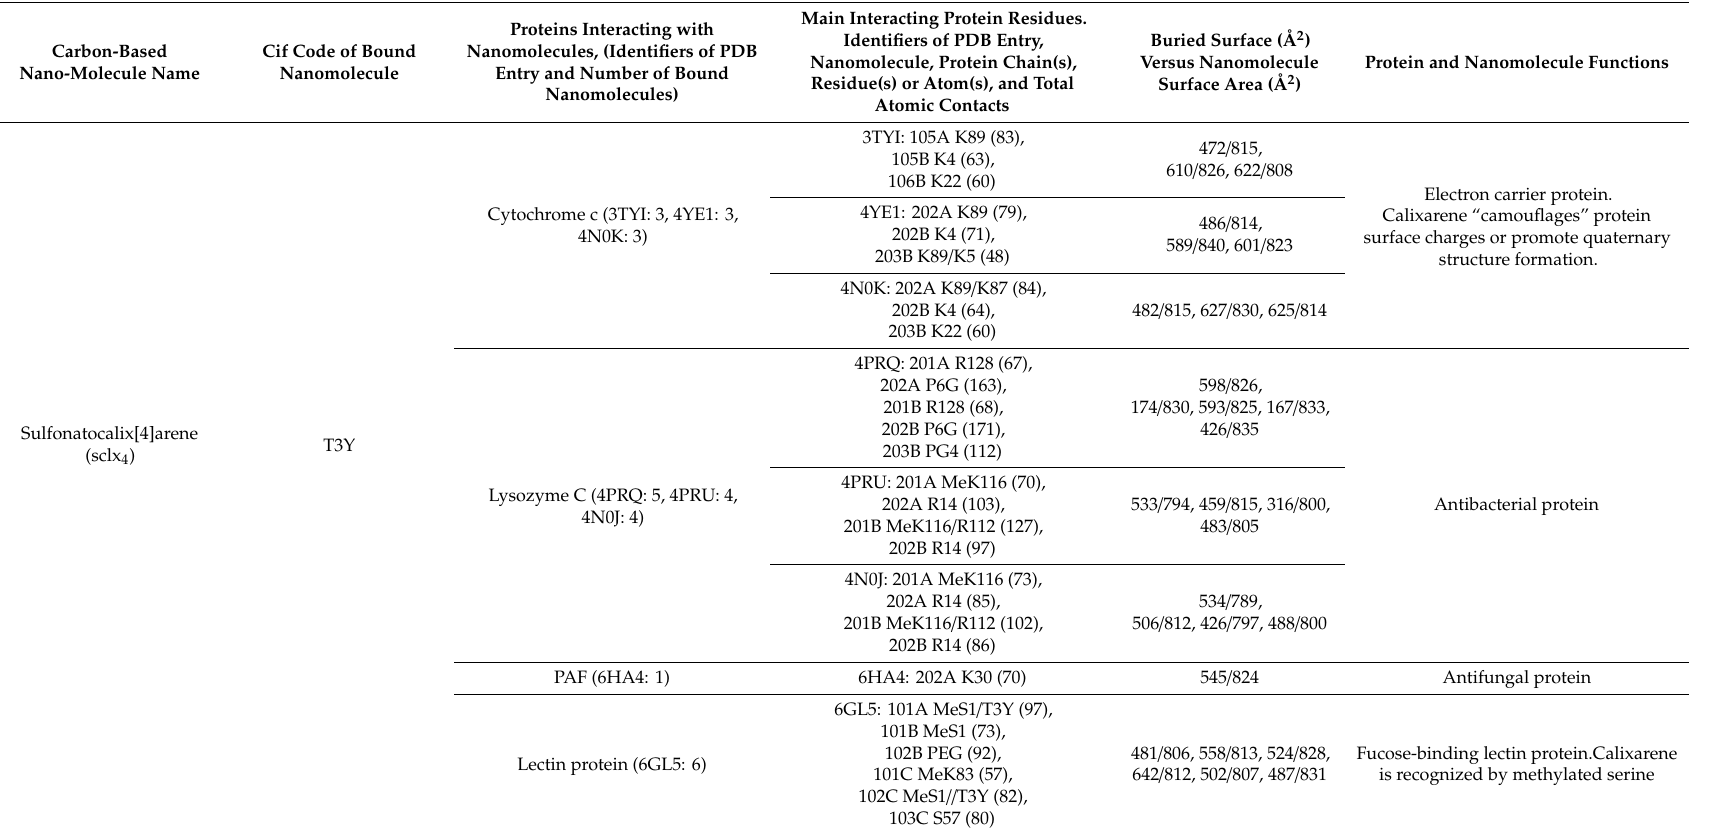
Fucose-binding lectin protein.Calixarene is recognized by methylated